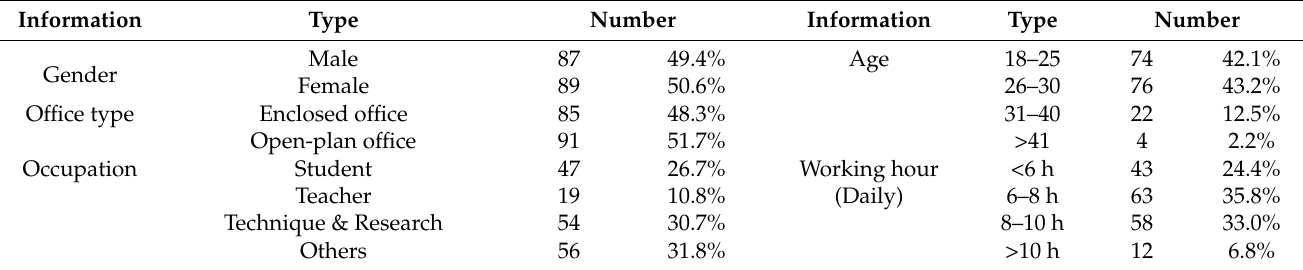
Table 3. Participants’ basic information in the AHP-based online questionnaire